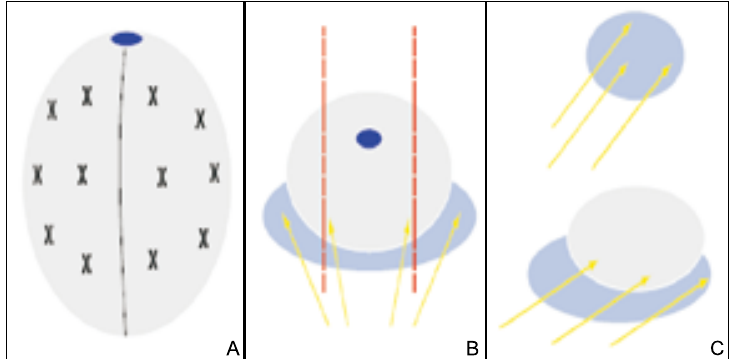
Figure 1 The needle deployment of systematic biopsy. (A) The coronal position with the deployment of 12 needles; (B) The cross section, the shaded part is the external gland; (C) The sagittal position. Figure C1 is the needle deployment beyond the red line of Figure B; Figure C2 is the inside deployment of the red line. The red line is the dividing line of the needle